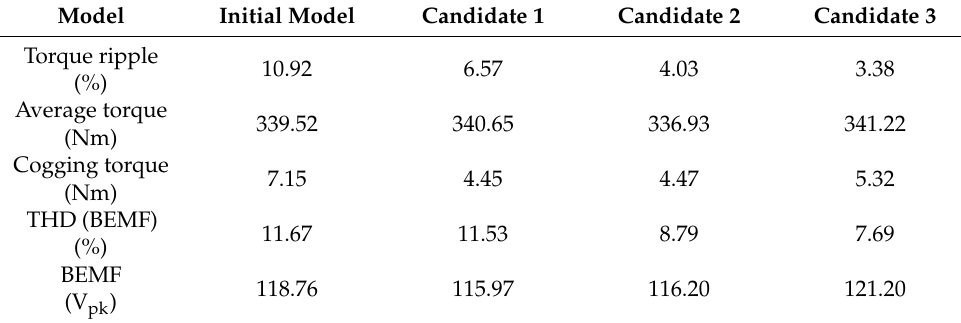
Table 5. Performance comparison of each